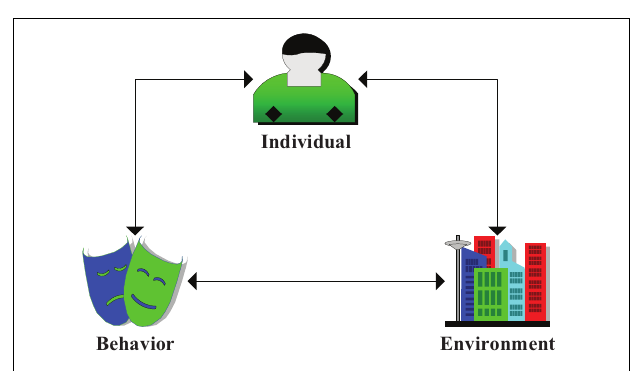
FIGURE 2 | The model of ternary interaction